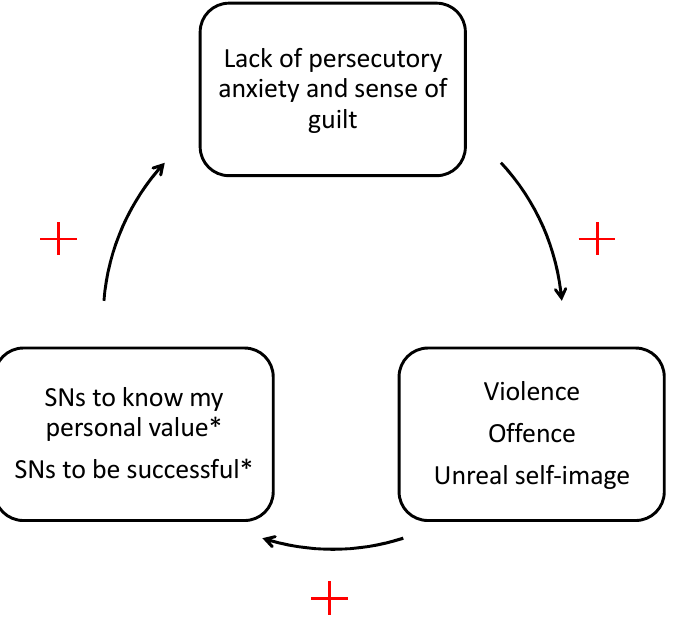
Figure 2. A psychological model on how SNs can turn out to be dangerous. Note. Items with * represent the riskiest uses of SNs, exposing the subject to potential dangers.